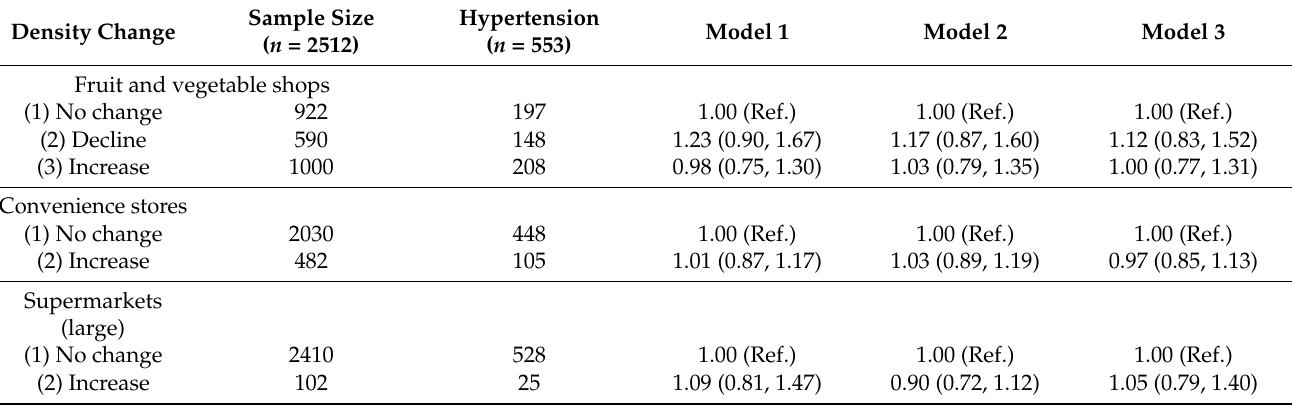
Table A2. Logistic regression demonstrating the association between neighborhood food